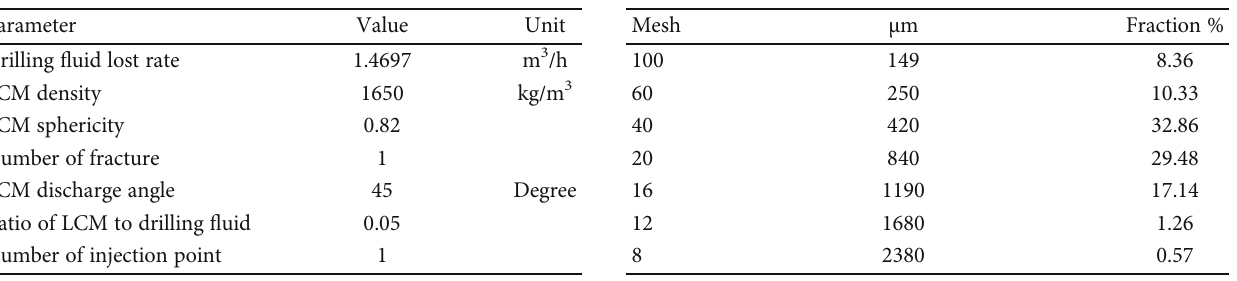
Figure 9: The trends of loss rate and cumulative volume for gravity displacement type of lost circulation. Table 3: Properties of LCM used in case study. Table 4: Side distribution of lost circulation